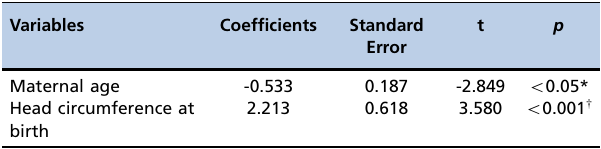
Table 4 - Predictors of the Test of Infant Motor Performance score in late preterm newborn infants at the age equivalent to